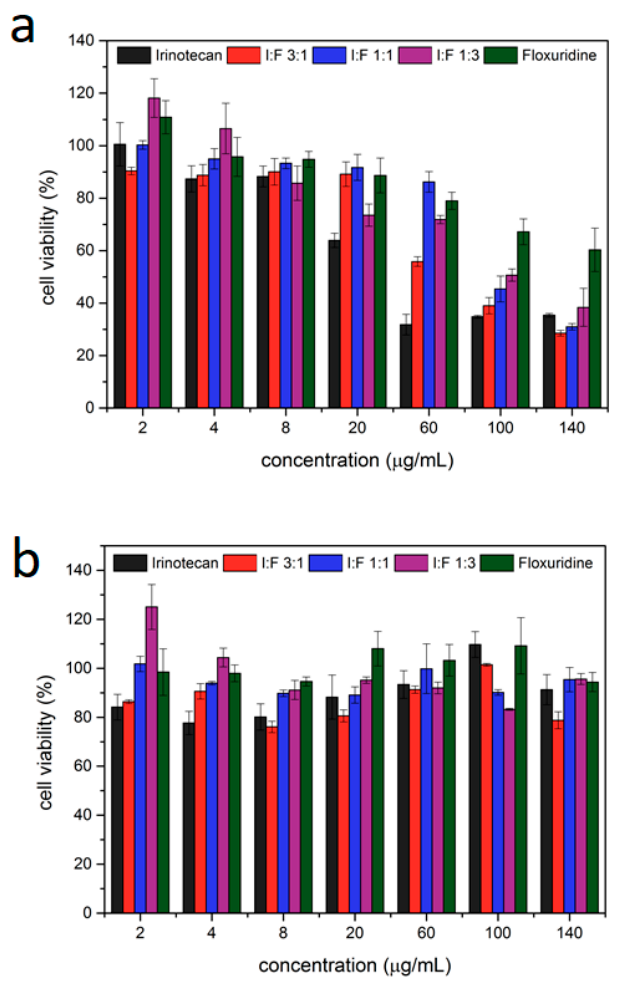
Figure 5. ( a ) MTT-assay of Lip-MIL-88A particles loaded with different ratios of irinotecan/floxuridine incubated in HeLa cells for three days. The error bars represent the standard deviation. ( b ) MTT-assay of the supernatant of Lip-MIL-88A particles loaded with different ratios of irinotecan/floxuridine after incubation in HeLa cells for three days. The error bars represent standard deviations.